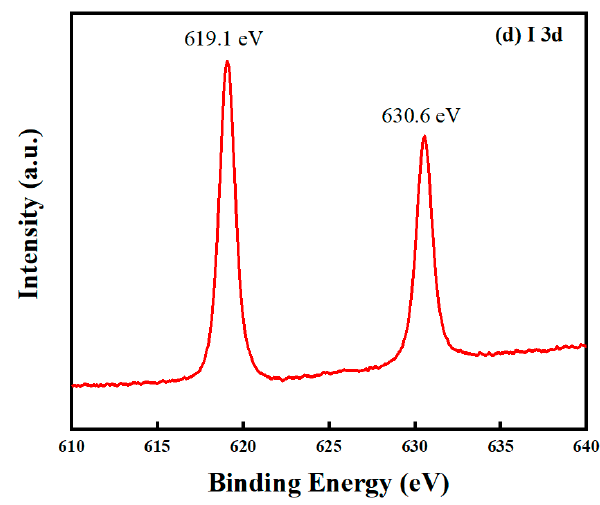
Figure 3. XPS spectra of AgI / ZnO (X = 0.4). ( a ) Zn 2p, ( b ) O 1s, ( c ) Ag 3d, ( d ) I 3d.